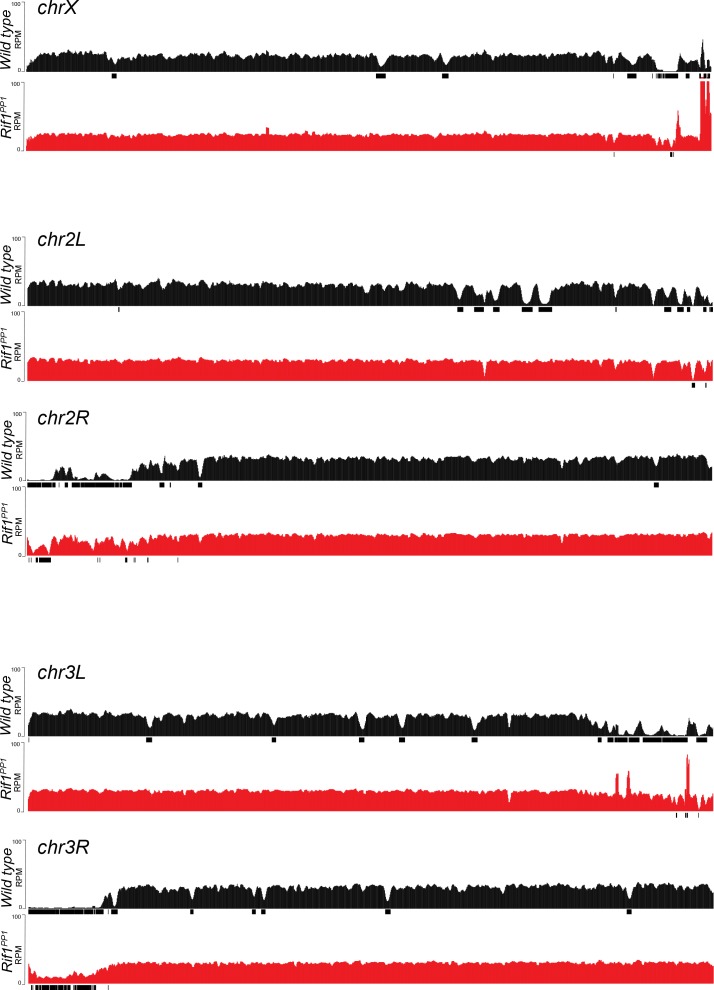
Genome-wide copy number profile of the Rif1PP1 mutant.Illumina-based copy number profiles of all chromosome arms except the fourth for larval salivary glands of the indicated genotypes. Black bars below each profile represent called underreplicated regions.